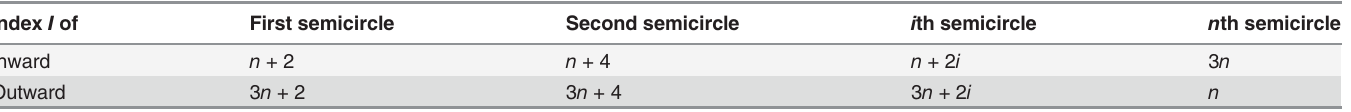
Table 2. Indices of rotation of semicircles in the next level (arising from a semicircle of general index I ). Index I